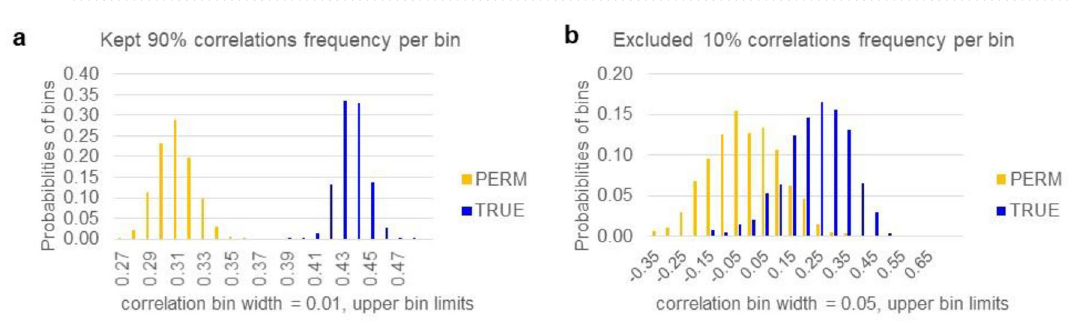
Figure 6. A visual comparison of CALF4 versus LASSO.2 approximations of age of onset as a z-score. ( a ) The correlation of CALF4 is reflected in trendline R 2 = 0.187. ( b ) For LASSO.2, R 2 = 0.110.